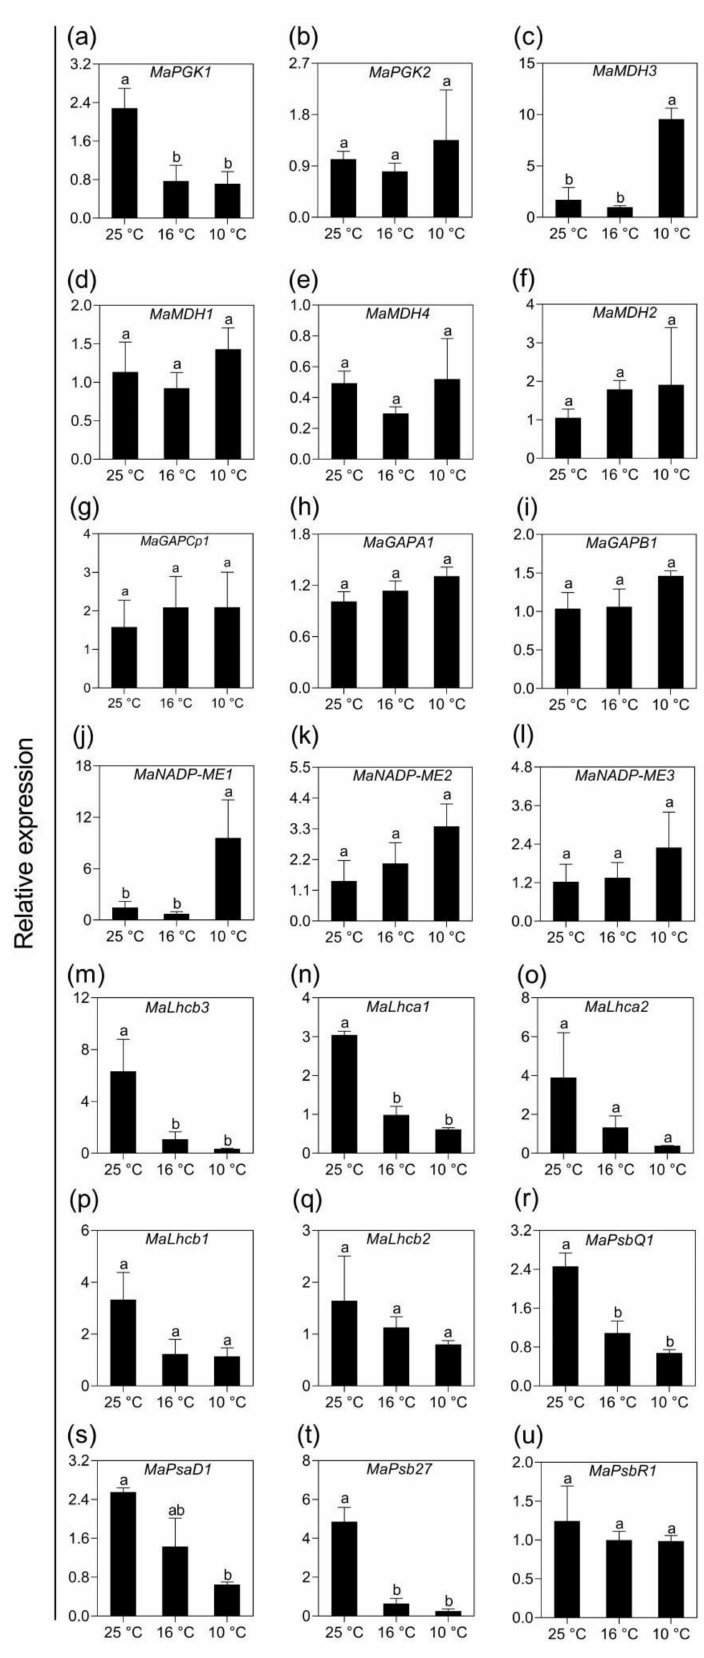
Figure 8. qPCR analysis of the expression of photosynthesis-related genes in banana ( Musa spp. AAA) exposed to low temperatures. ( a – b ) Phosphoglycerate kinase genes; ( c – f ) Malate dehydrogenase